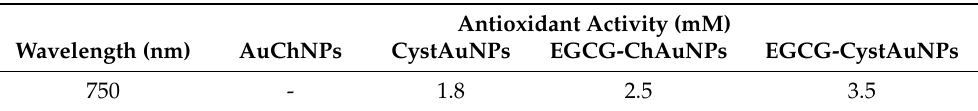
Table 2. ABTS radical scavenging activity of ChNPs, CystAuNPs, EGCG-ChAuNPs and EGCG- CystAuNPs.